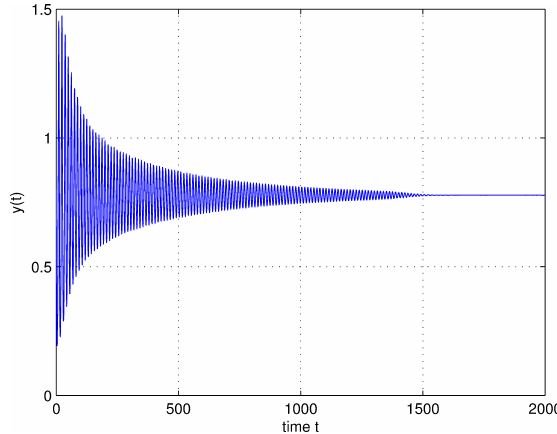
Fig. 2. The trajectory graph of system .26/ in t (cid:0) y plane with (cid:28) 1 D 0:5 , (cid:28) 2 D 0:4 and (cid:28) 3 D 0:3 . The initial value is .x.0/ D 0:8;y.0/ D 0:8;z.0/ D 0:7/ .